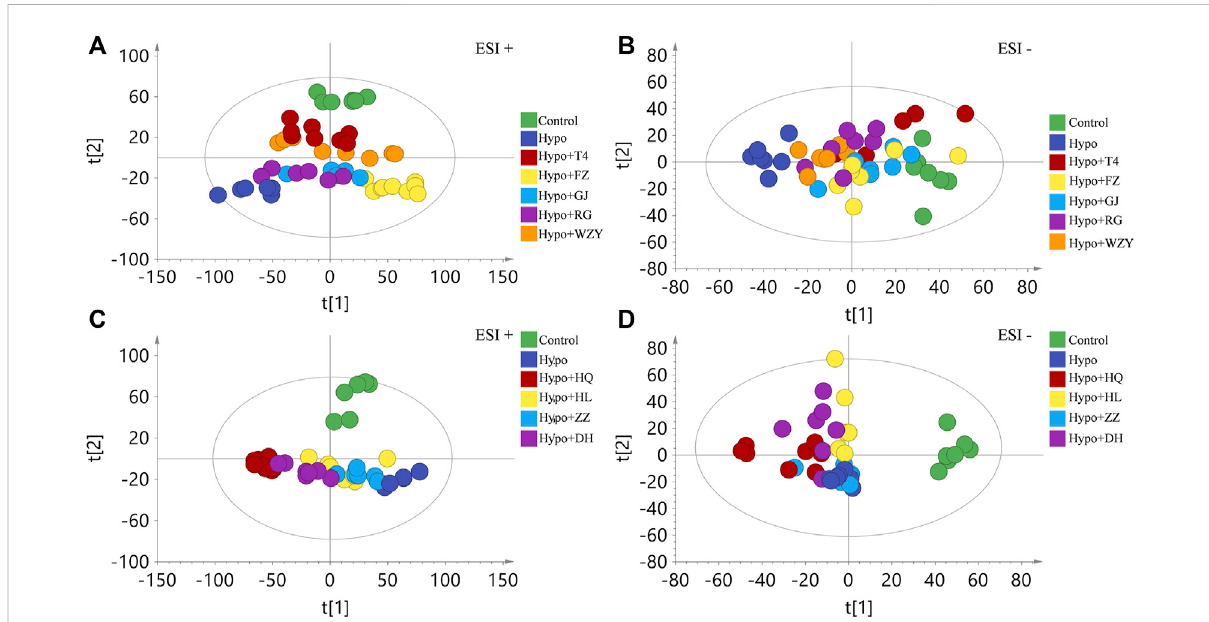
Theprincipalcomponentanalysis(PCA)analysisofthefourtypical “ hot ” propertyherbs (A,B) representinthepositiveandnegativeionmodesof the ESI, respectively) and the four typical “ cold ” property herbs (C,D) represent in the positive and negative ion modes of the ESI, respectively) effect on the hypothyroidism rats ’ metabolic pro fi le ( n =